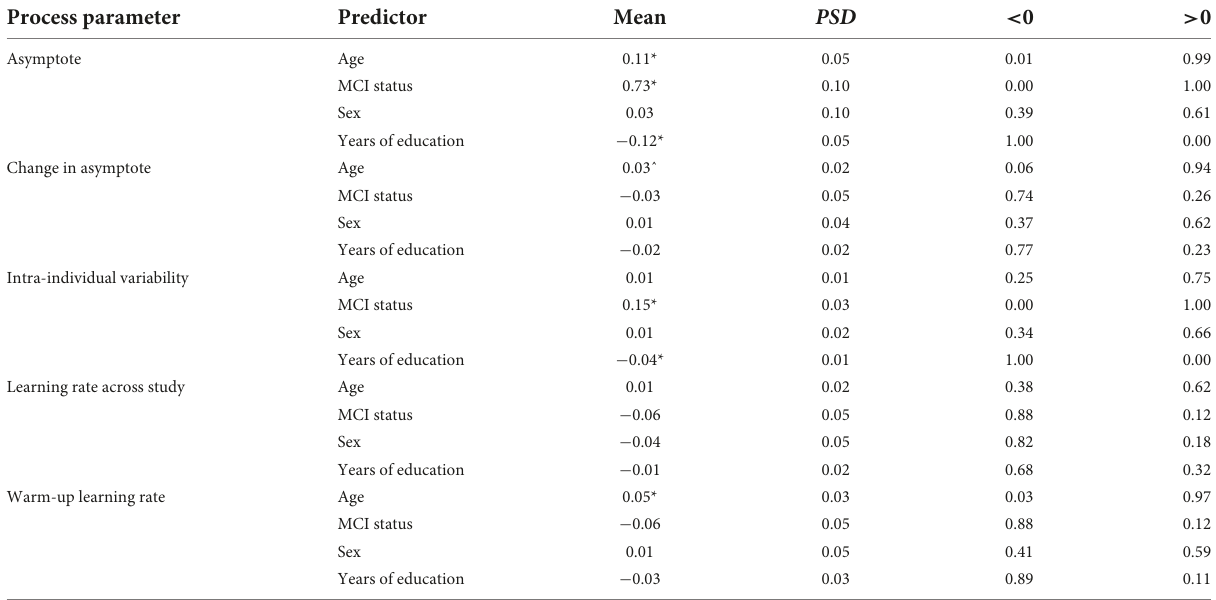
TABLE 2 Summary of links between cognitive performance characteristics of the symbol search task and selected explanatory variables. Process parameter